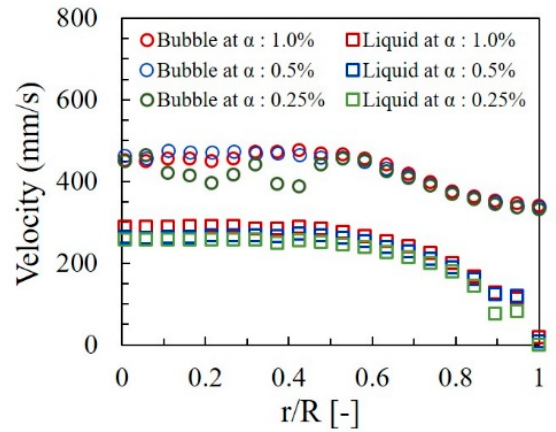
Figure 19. Bubble diameter distribution.